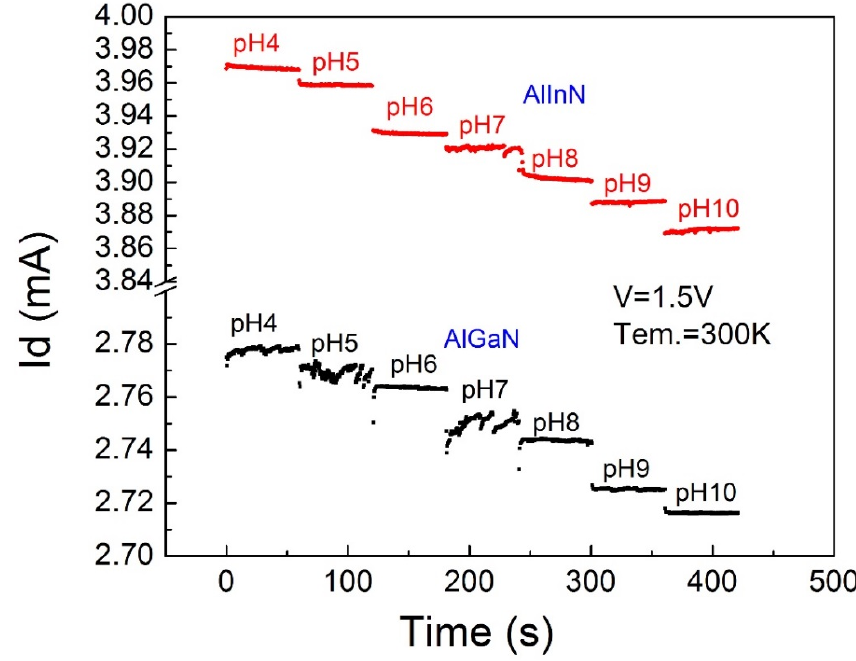
Figure 5. The drain to source current I ds of two structures’ sensors during real-time measurement of the pH value change from 4–10 when the V ds equal to 1.5 V with a time interval of 1 s. The numbers indicate the corresponding pH values in a mixed solution of HCl and NaOH in water and the pH values measured with a calibrated pH meter.